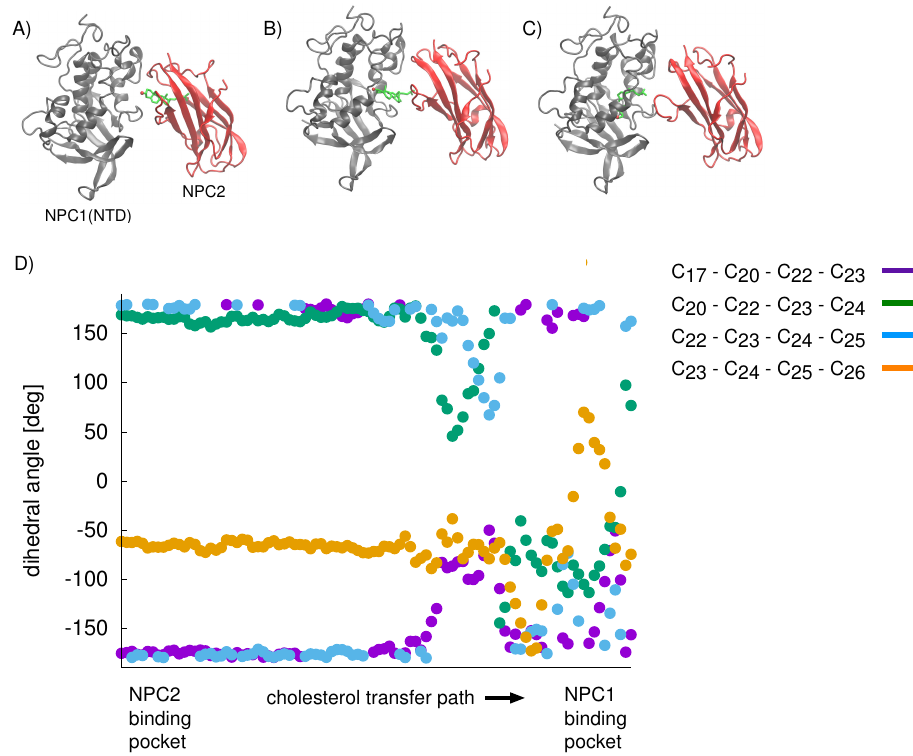
Figure 10. The cholesterol transfer path involves: ( A ) cholesterol leaving the binding pocket of the NPC2 protein; ( B ) crossing a transition state; and ( C ) entering the binding pocket of the NPC1(NTD). ( D ) For cholesterol transfer based on the California model, the conformation of the cholesterol tail was analyzed during the transfer from the NPC2 binding pocket to the NPC1(NTD) binding pocket. Four dihedral angles were calculated: C 17 -C 20 -C 22 -C 23 (purple), C 20 -C 22 -C 23 -C 24 (green), C 22 -C 23 -C 24 -C 25 (blue), and C 23 -C 24 -C 25 -C 26